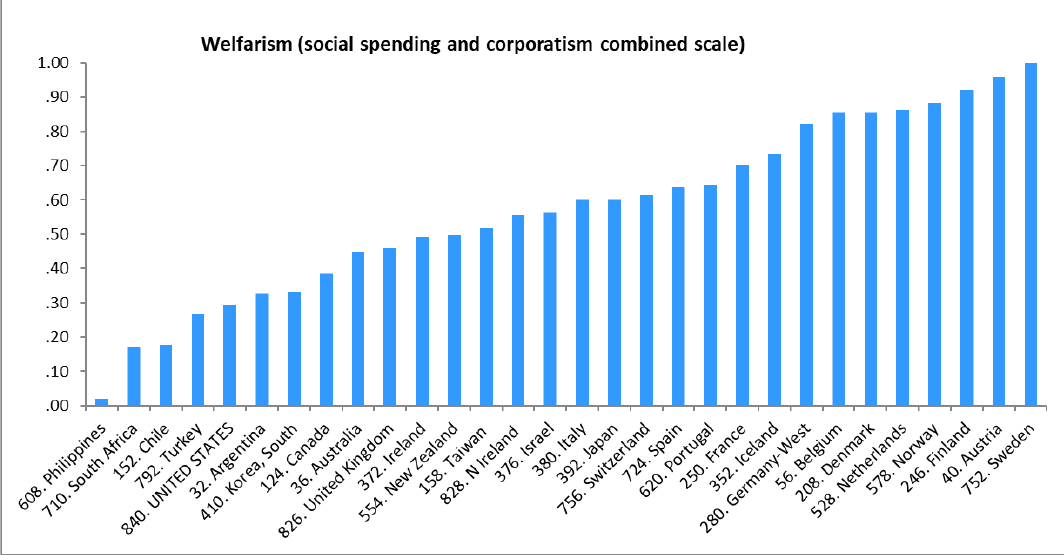
Figure 4. International patterns of welfarism. Welfarism is measured by the scale combining social spending and corporatism. Nations are identified by UN code and common English name. spending and corporatism. Nations are identified by UN code and common English